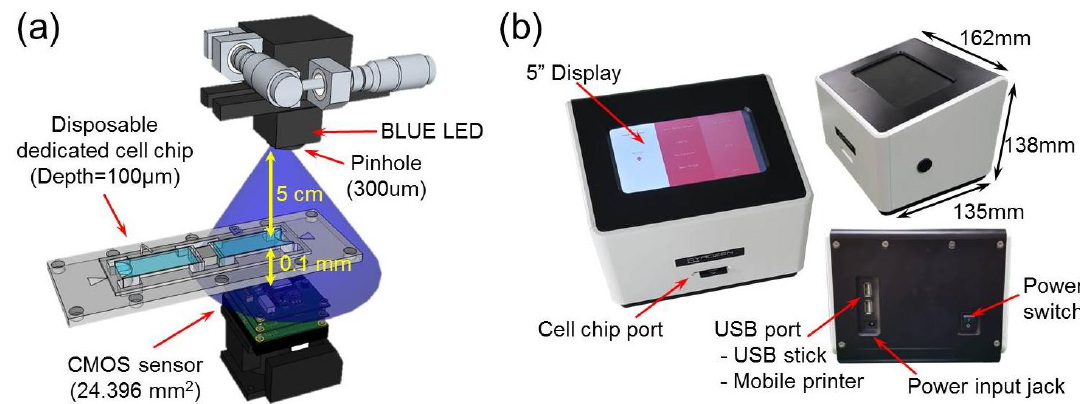
Figure 1. Lens-free cell analyzer, NaviCell. ( a ) The optical part consists of a blue LED, a 300 μm pinhole for coherent illumination to a sample chip and a CMOS image sensor for acquiring images from the sample; ( b ) For convenient usability, a 5-in. touch display is mounted at the top of the device, which allows for the reporting of quantitative results and for viewing images of the samples without additional equipment. The NaviCell is operated by a proprietary program based on an Android system. Samples for analysis are prepared on a disposable chip which was developed to increase the shadow intensity of the cell. Table 1. Overview of the NaviCell and commercial cell counters.